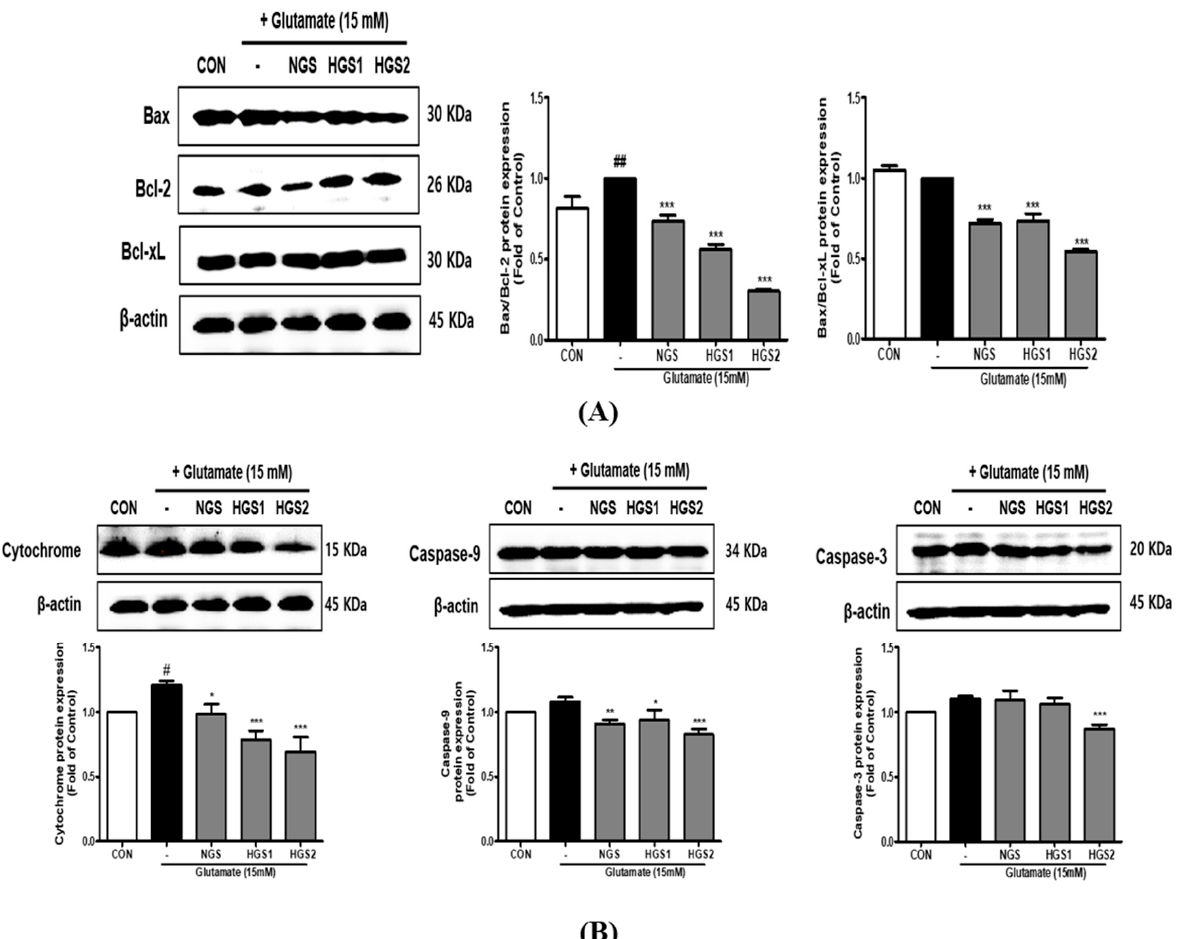
Figure 5. Effect of HGS on glutamate-induced Bcl-2 family protein expression in PC12 cells. PGS protects PC12 cells from glutamate-induced apoptosis. Cells were treated with HGS (20 µ g/mL) or the control (0.2% DMSO) for 1 h followed by glutamate (15 mM) for 24 h. Proteins were analyzed by Western blotting using β -actin as the loading control. ( A ) Bax/Bcl-xL and Bax/Bcl-2 protein expression in the mitochondria. ( B ) Cytochrome c and caspase-9 and -3 expression in mitochondria. Data are means ± standard errors of the mean (SEM). Significance was determined by a one-way ANOVA with Tukey’s post hoc multiple comparison test. # p < 0.1, ## p < 0.01 significance compared with the control (white bar). * p < 0.1, ** p < 0.01, and *** p < 0.001, significance compared with the glutamate-treated cells (black